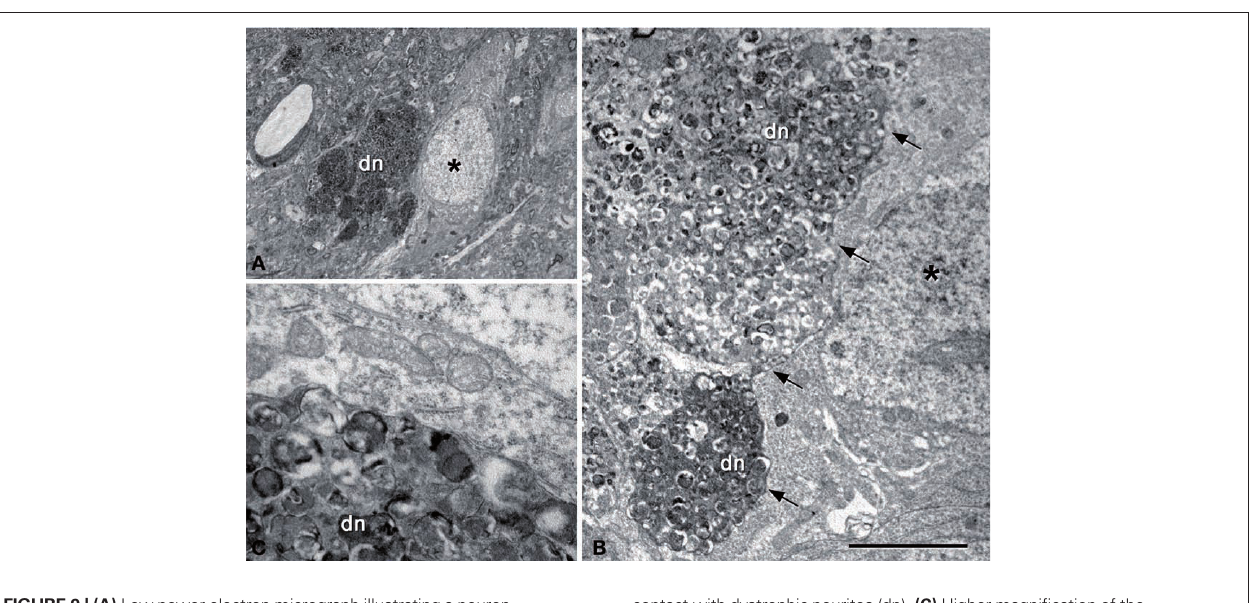
FIGURE 9 | (A) Low-power electron micrograph illustrating a neuron (asterisk) in contact with a plaque (dn, indicates dystrophic giant neurites fi lled with degenerating organelles). (B) Higher magnifi cation of (A) showing that a large portion of the surface of the soma (arrows) is in